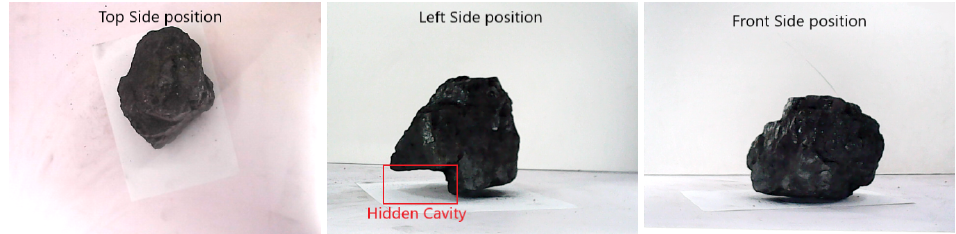
Figure 3. Samples 3_Side images showing the cavity problem.